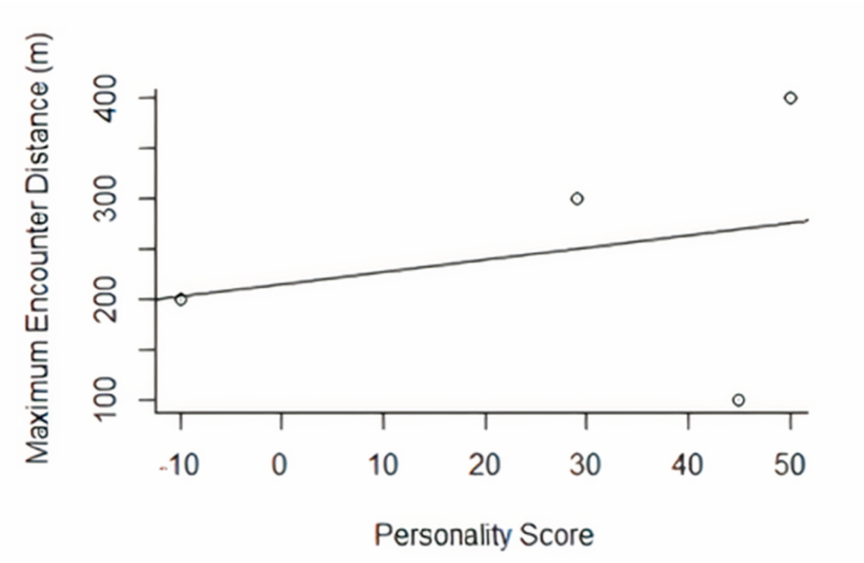
Figure 3. A linear regression showing the potential relationship between personality score and maximum encounter distance performed on a translocated group of red squirrels into the Braichmelyn forest in 2017 (R 2 = − 0.4014, n / sf = 4, p =